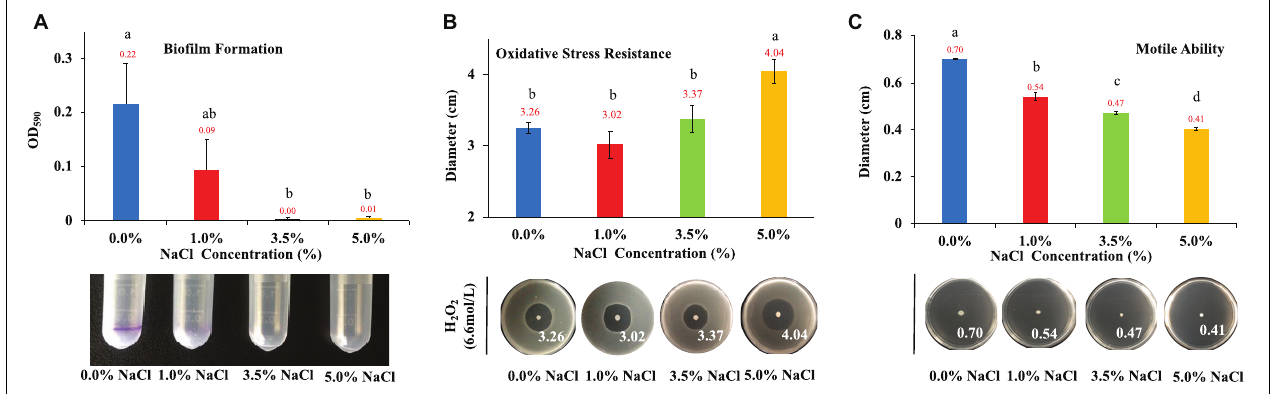
FIGURE 3 | Effects of NaCl on E. coli biofilm formation, oxidative stress resistance, and motile ability. (A) Effects of different NaCl concentrations on E. coli biofilm formation. (B) Influences of different NaCl concentrations on E. coli oxidative stress resistance. (C) Effects of different NaCl concentrations on E. coli motile abilities. Tukey’s Honestly Significant Difference (HSD) test was performed, which compared the means of every group to the means of every other group simultaneously. Means denoted by a different letter indicated significant differences among groups ( P -value <